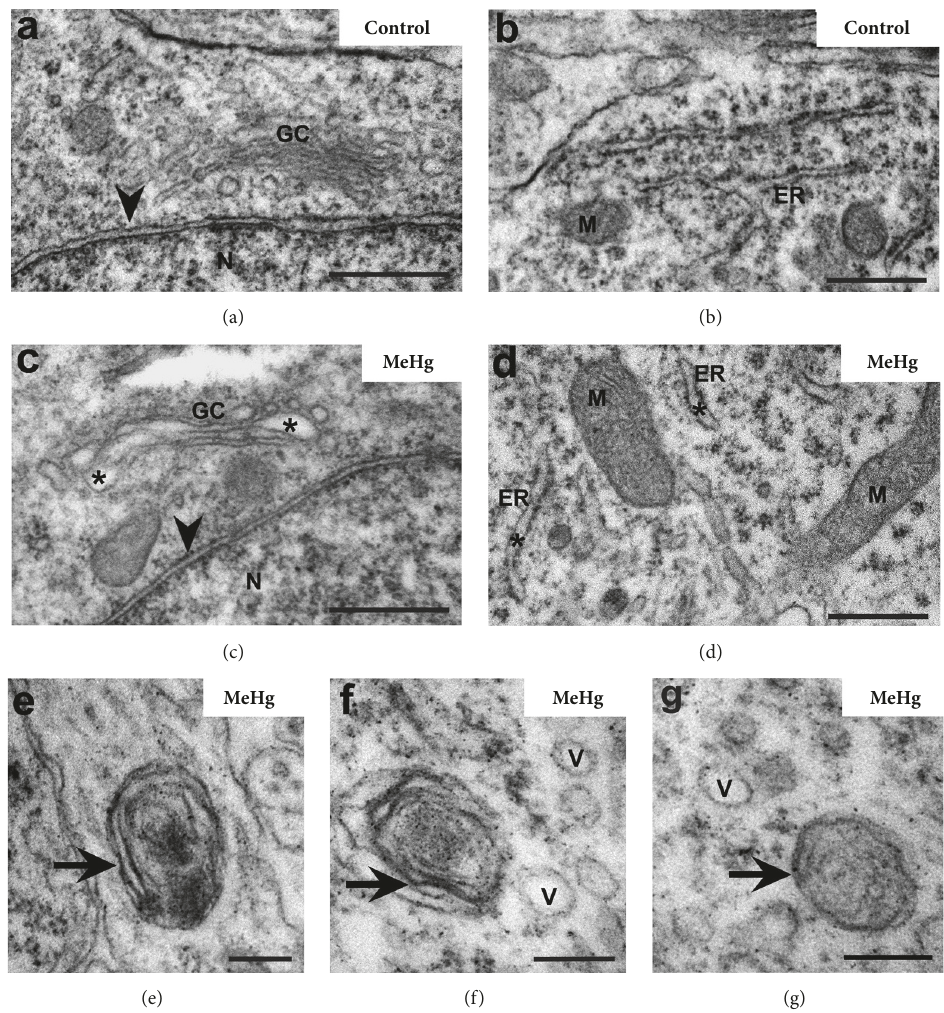
Figure 1: Effect of MeHg on the endomembrane system of the spinal cord embryos . Electron micrograph of the E10 spinal cord mantle layer showing Golgi complex (GC) and endoplasmic reticulum (ER) in control and MeHg-treated embryos. Slightly dilated cisterns ( ∗ ) in the GC and ER and myelin-like membranous inclusions (arrows) were observed. Note the vesicles (V) close to the myelin-like inclusions. Nuclear envelope (arrowhead), nucleus (N), and mitochondria (M). Scale bars: (a–d) 0.5 𝜇 m; (e–g) 200